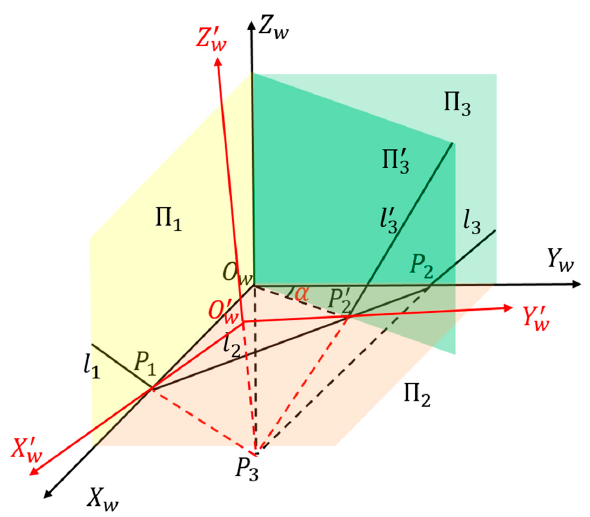
Figure 5. Schematic diagram of the impact of the deviation from orthogonality.